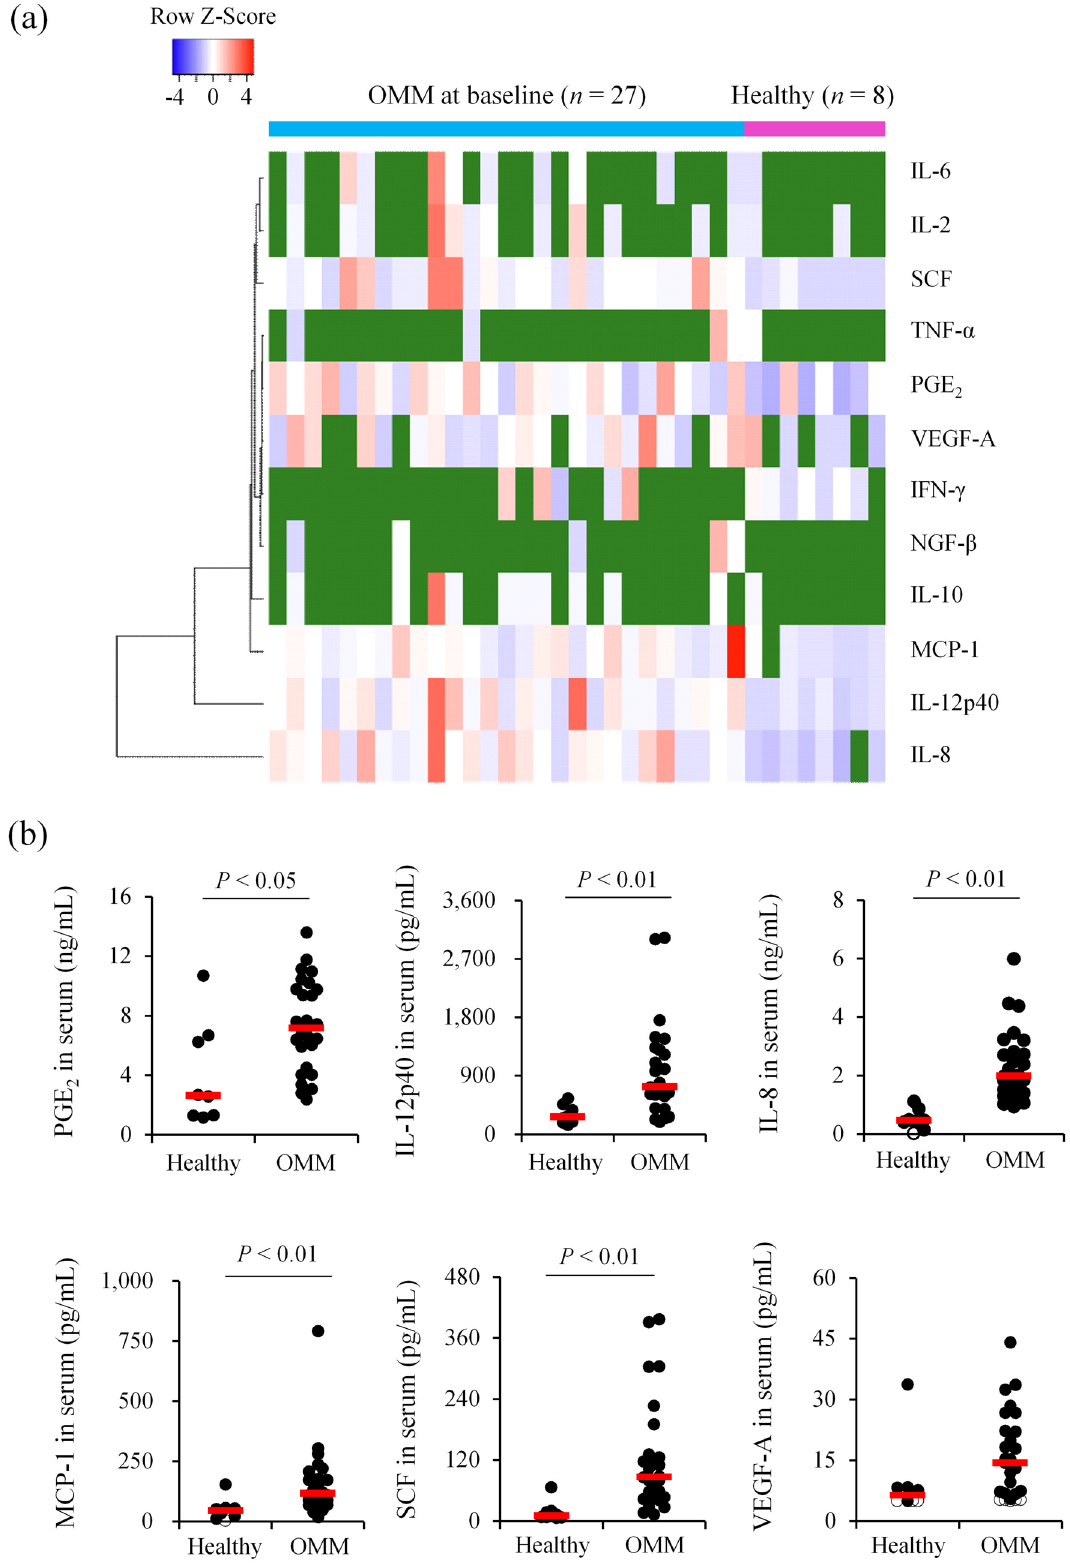
Figure 1. Serum concentrations of several immune modulators are elevated in dogs with pulmonary metastatic oral malignant melanoma (OMM). ( a ) Heat map depicting the serum concentrations of each measured factor (as Z-Scores) in dogs with OMM prior to treatment ( n = 27) and in healthy dogs ( n = 8). Missing values (below the lower limit of quantitation [LLOQ]) are shown in dark green. ( b ) Comparison of serum concentration between OMM and healthy dogs. Red bars indicate the median values. Values below LLOQ are shown as open circles. Statistical analysis was performed using Mann–Whitney U